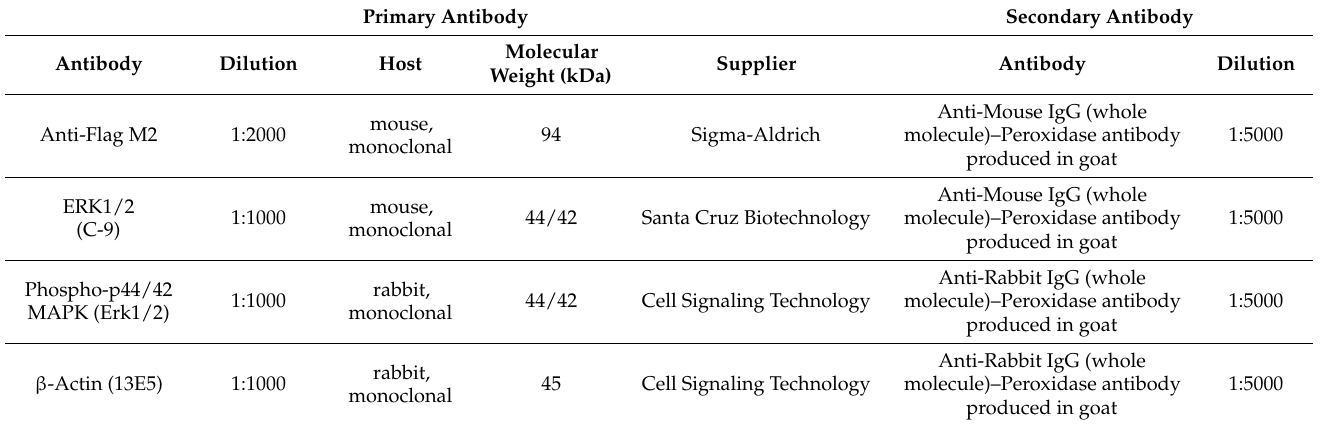
Table 5. List of primary and secondary antibodies used for Western